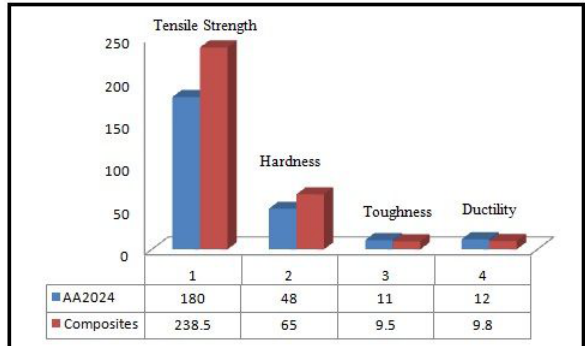
Figure 10: Mechanical Properties at optimum Reinforcement Param- eters